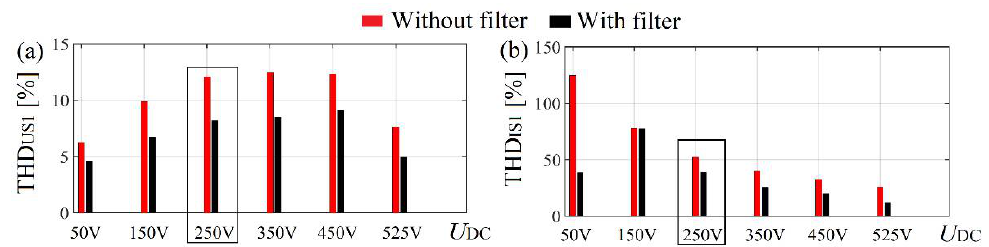
Figure 50. THD of grid voltage ( a ) and current ( b ) for different U DC : the case without the filter is compared to the case with filter.